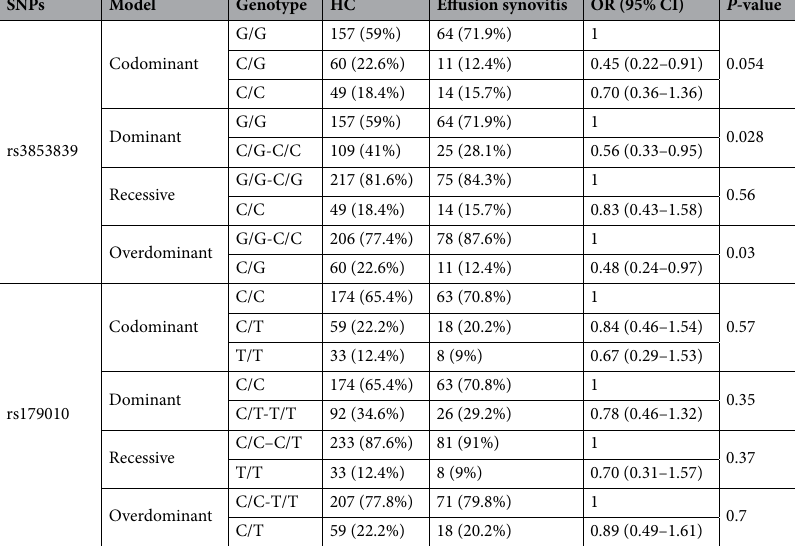
Table 7. Association between TLR7 polymorphism and the risk of effusion with synovitis in Knee OA. Knee OA osteoarthritis patients group, HC healthy control group, OR Odds ratios, CI confidence intervals; The data adjusted by smoke + drinking + age +